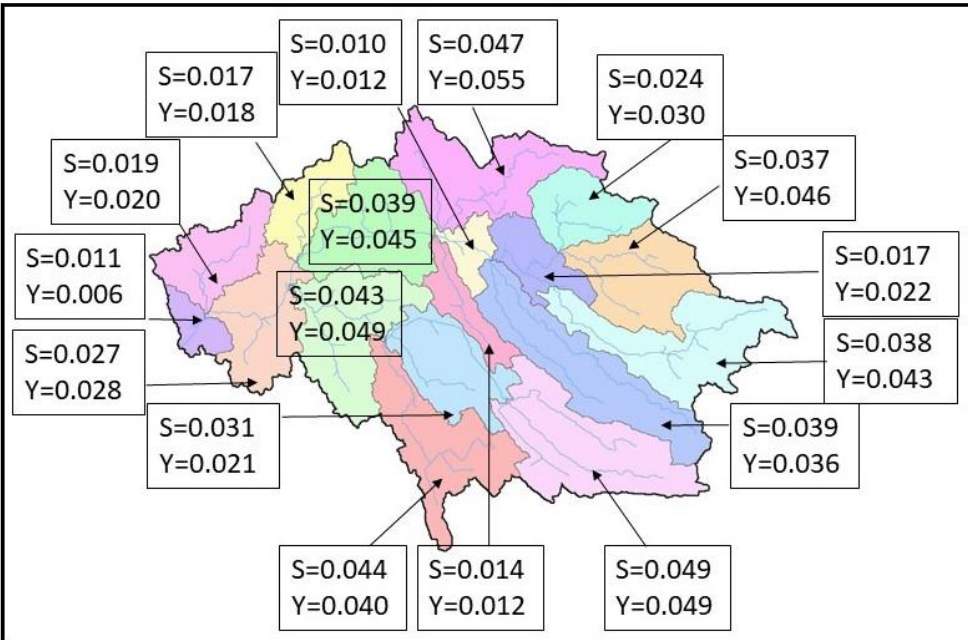
Figure 9. Feasible storage capacity (S) and withdrawals (Y) in each large sub-basin of Kalu Ganga for the entire basin to stay on the Mid scenario if the cumulative storage capacity were increased to 0.5 MAR units. S and Y values given in terms of MAR units of the entire basin.